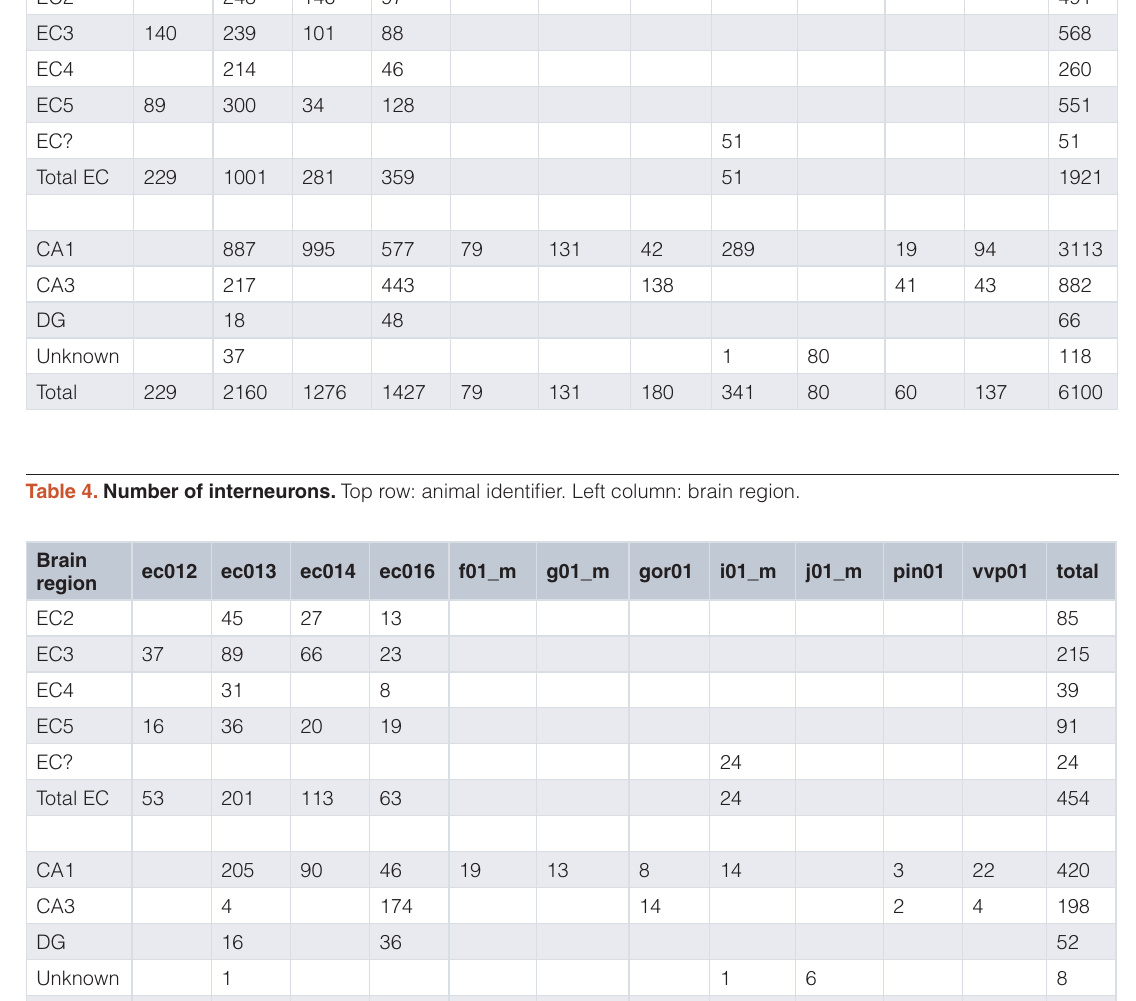
Table 3. Number of principal cells. Top row: animal identifier. Left column: brain region. Brain region